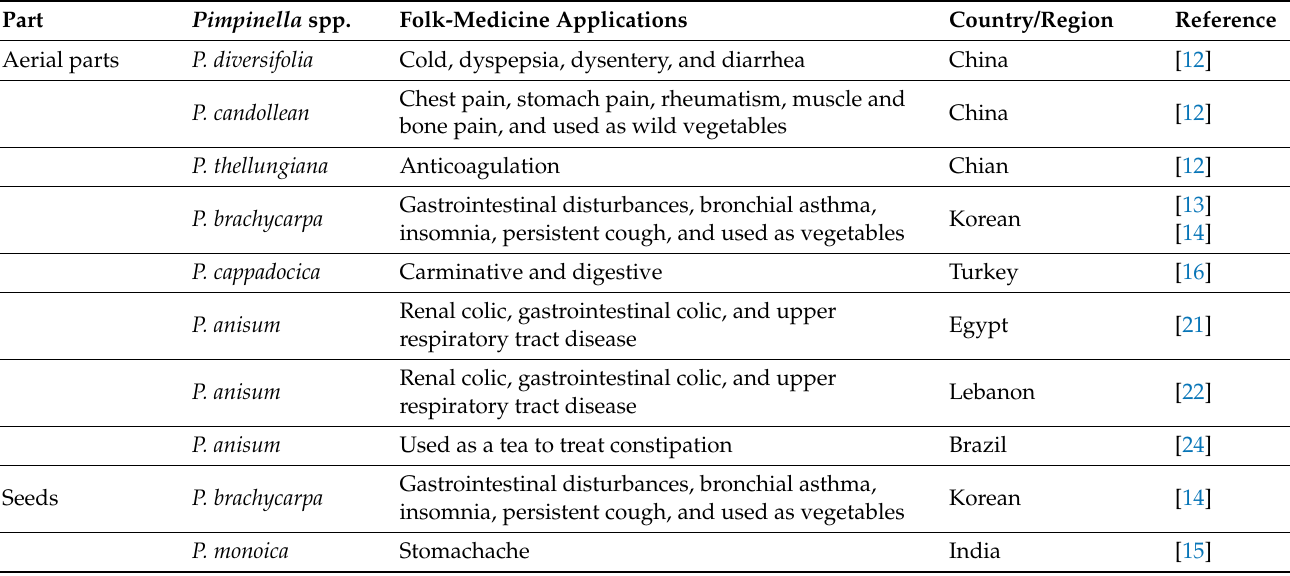
Table 1. The folk-medicine applications of some Pimpinella species in several